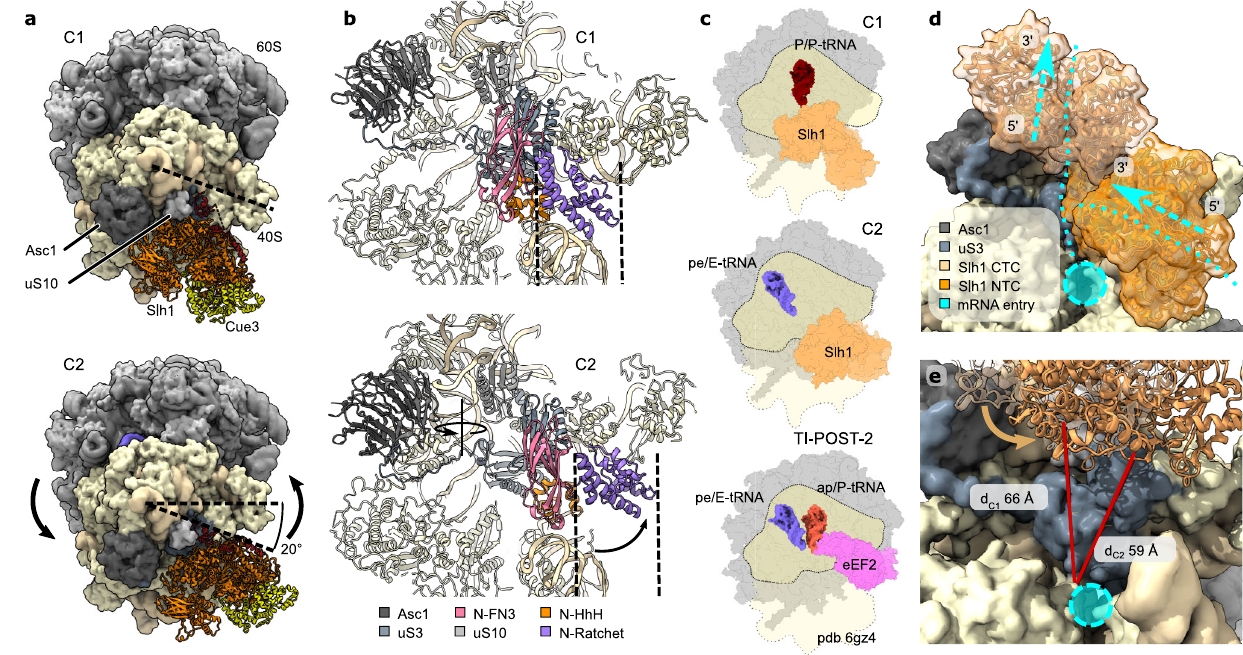
Fig. 4 | Conformational dynamics of the RQT-ribosome complexes. a , b ComparisonofC1andC2statesoftheRQT-80Scomplex. a Topviews;inC1,the dashed line marks the position of the 40S head; in C2, the rotation direction and resulting net rotation angle for the head-swivel movement is indicated (20°). For clarity the molecular model of the ribosome was converted to low-pass fi ltered density. b View focusing on the main 40S contacts of the RQT NTC and its repo- sitioning.Thesolidlinein( b )displaystherotationaxisofthe40Sheadswivel;RQT undergoesanadditionalmovementand dashed linesassistinassessing theshiftof RQTdomains relative to the invariant 40S body. HhH = helix-hairpin-helixdomain, FN3 = fi bronectin type III domain. c Top views of cartoon representations